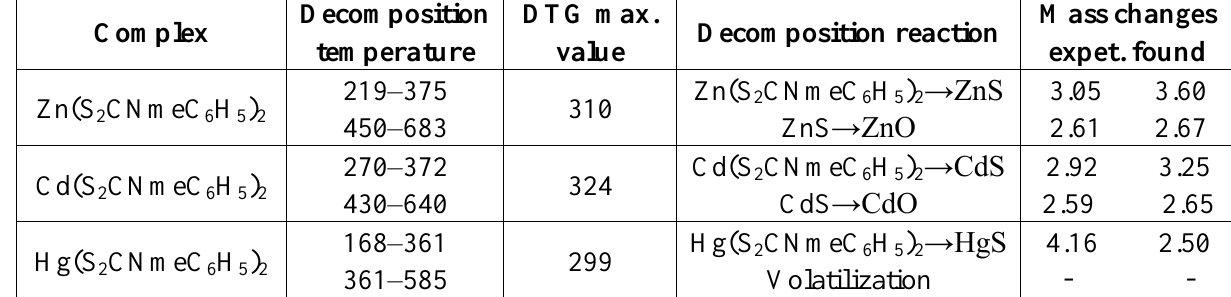
Table 1. Temperature ranges of thermal decomposition and modes of various decomposition